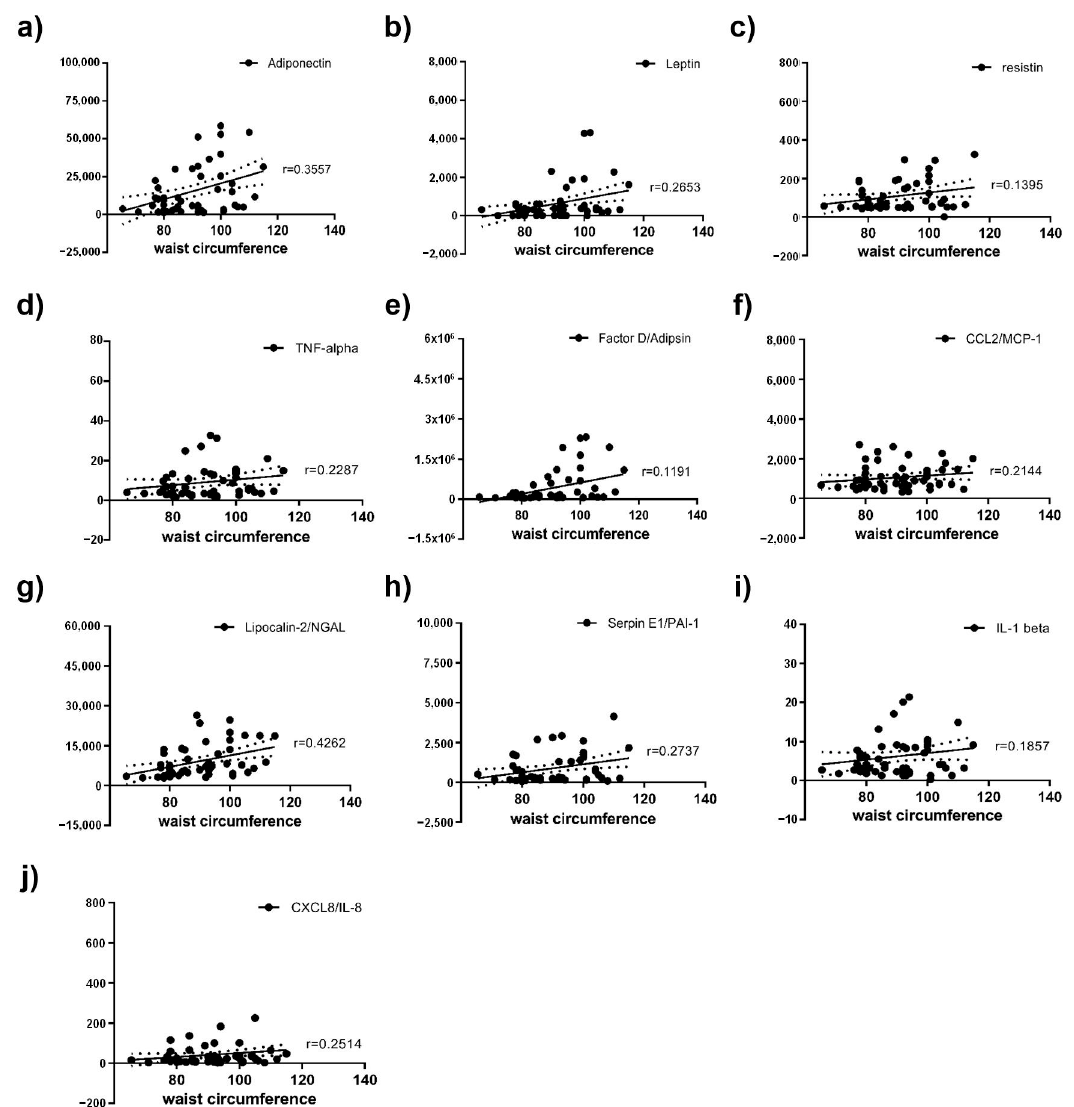
Figure 4. Scatterplots of correlations of WC and adipokines, including ( a ) adiponectin, ( b ) leptin, ( c ) resistin, ( d ) TNF- α , ( e ) Factor D/adipsin, ( f ) CCL2/MCP-1, ( g ) lipocalin-2/NGAL, ( h ) Serpin E1/PAI-1, ( i ) IL-1 β , and ( j ) CXCL8 (IL-8) in the overall groups.